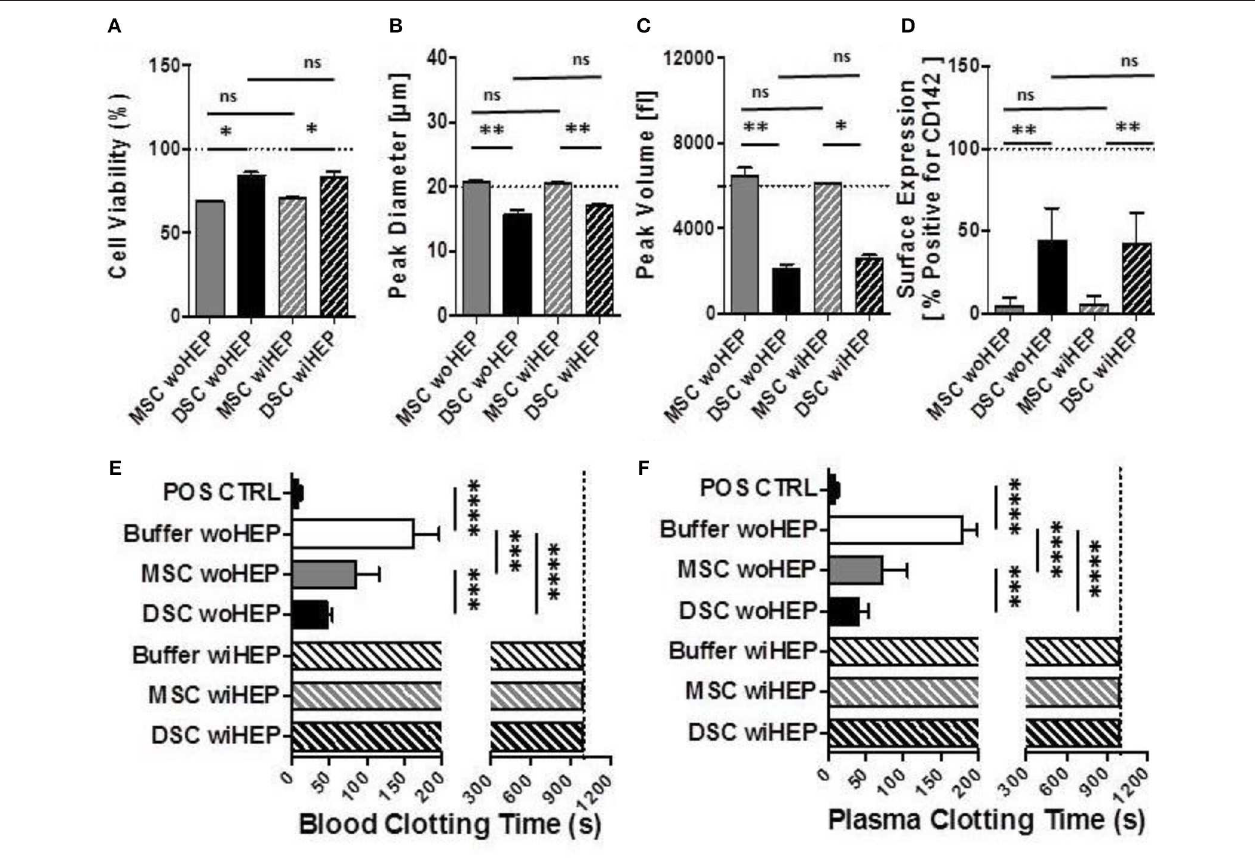
FIGURE 7 | Cell morphology, immunophenotype, and in vitro clotting analysis of stromal cells prepared with and without addition of heparin. In order to simulate the preparation and formulation of our clinical products, aliquots of cryobanked therapeutic bone marrow mesenchymal stromal cells (MSC) and placenta-derived decidua stromal cells (DSC) were thawed, reconstituted and supplemented in buffer supplemented with or without low-dose heparin (HEP) as commonly done during clinical procedures, and then evaluated for viability, phenotype, and clotting time in human blood and plasma. (A–C) Cell suspensions of stromal cell batches from different donors ( n = 4 each cell type) were analyzed with automated electrical impedance-based CASY counter for quantification of parameters of importance for systemic cell infusion: (A) Cell viability (%), (B) Peak diameter (um: micrometers), and (C) Peak volume (fL: femtoliters), (D) Flow cytometric analysis for cell surface expression of Tissue Factor (CD142, % of cells positive, n = 8) compared to isotype control, and (E,F) Analysis of clotting time (in seconds, n = 14 tests) after exposure of stromal cells (15,000 cells/mL) resuspended with and without heparin (10 U/mL) to fresh recalcified human blood (E) or plasma (F) , using a semiautomatic 10-channel ball coagulometer. Mean ± SD. * P < 0.05, ** P < 0.01, *** P < 0.001, and **** P < 0.0001, and ns, not